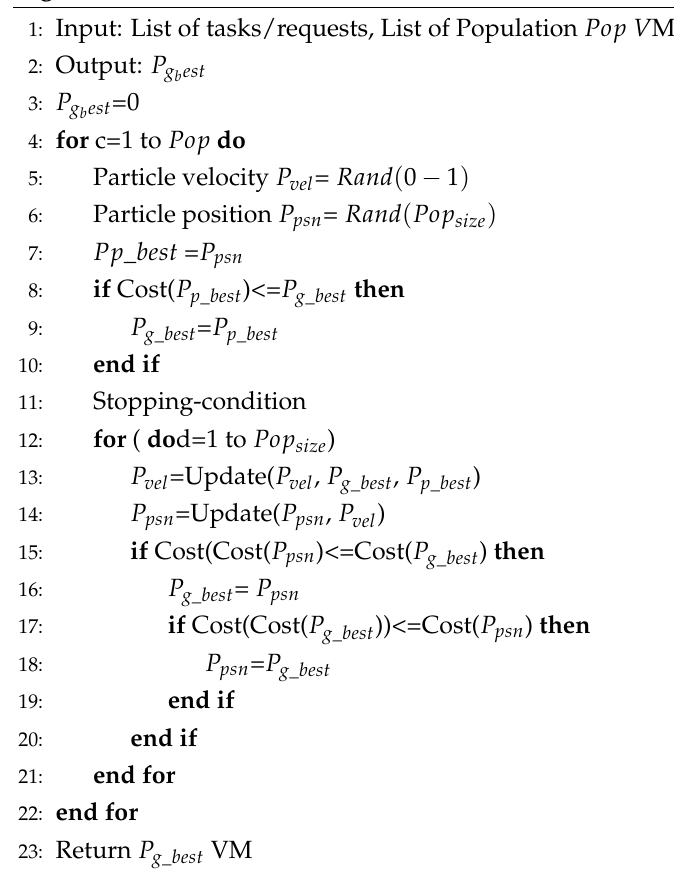
Algorithm 3 PSO-based resource